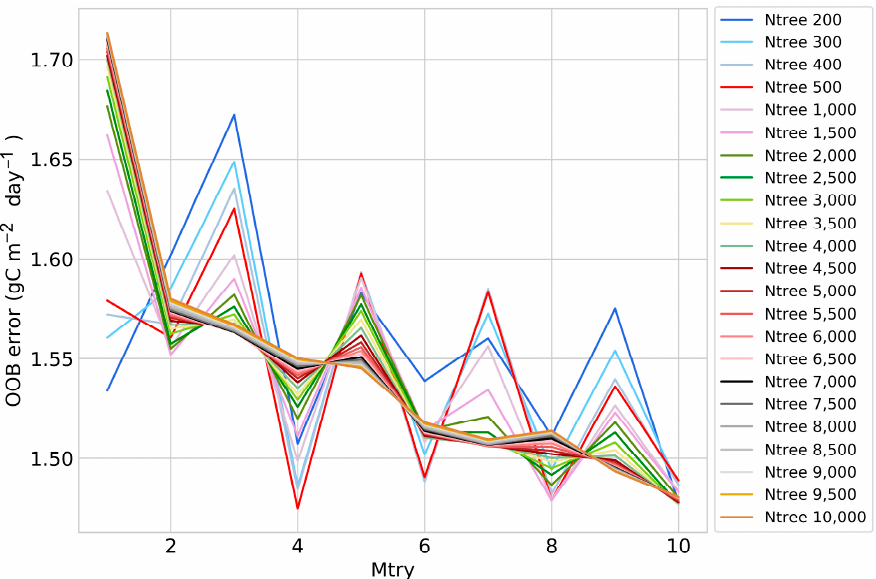
Figure 5. Influences of Ntree and Mtry values on RF model, and selection of the optimized parameters (Ntree and Mtry) for RF model based on the OOB error.